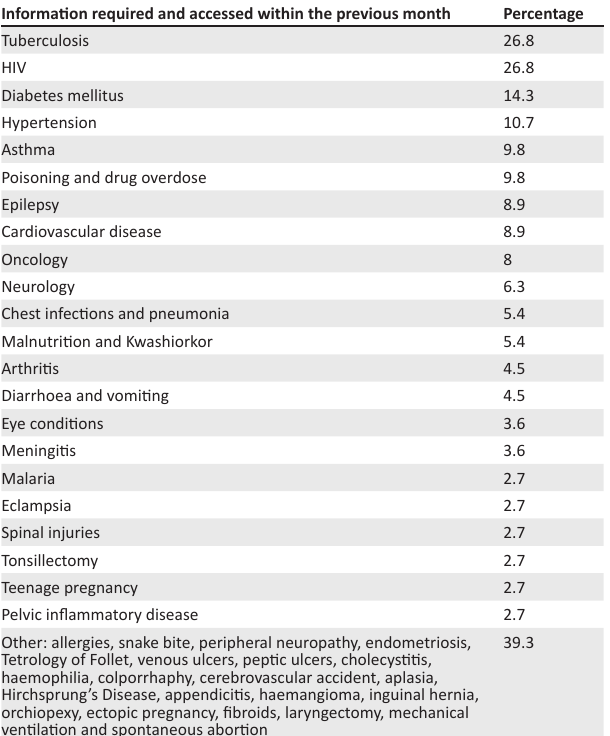
TABLE 1: Information needed and accessed within the previous month ( n = 112).